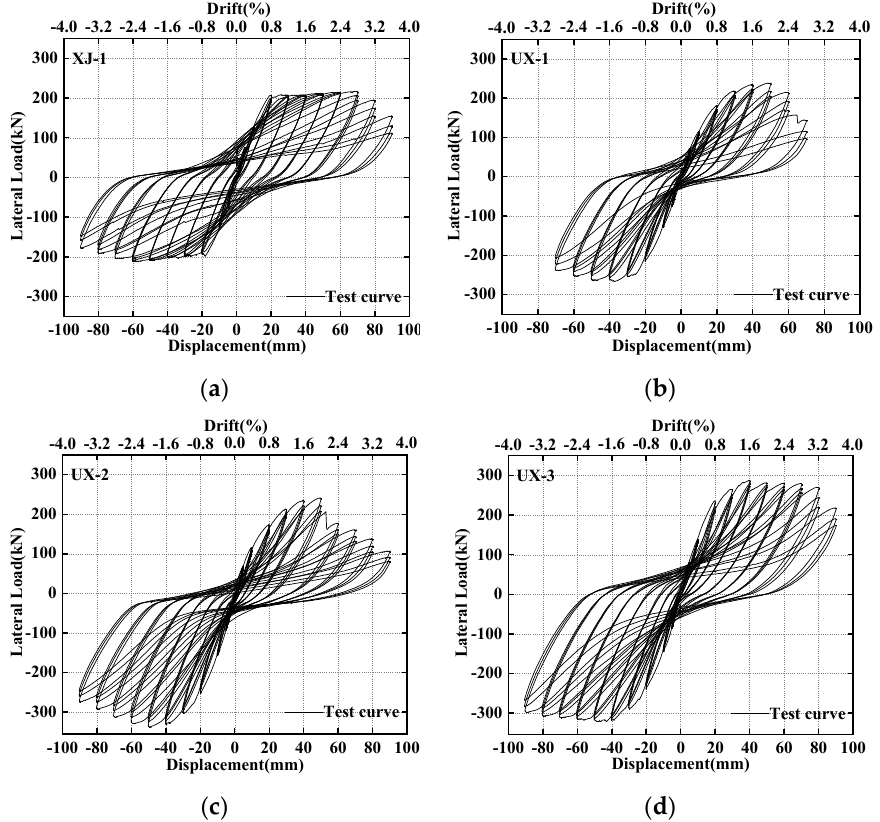
Figure 9. Hysteresis curve for each specimen: ( a ) Specimen XJ-1; ( b ) Specimen UX-1; ( c ) Specimen UX-2; ( d ) Specimen UX-3.